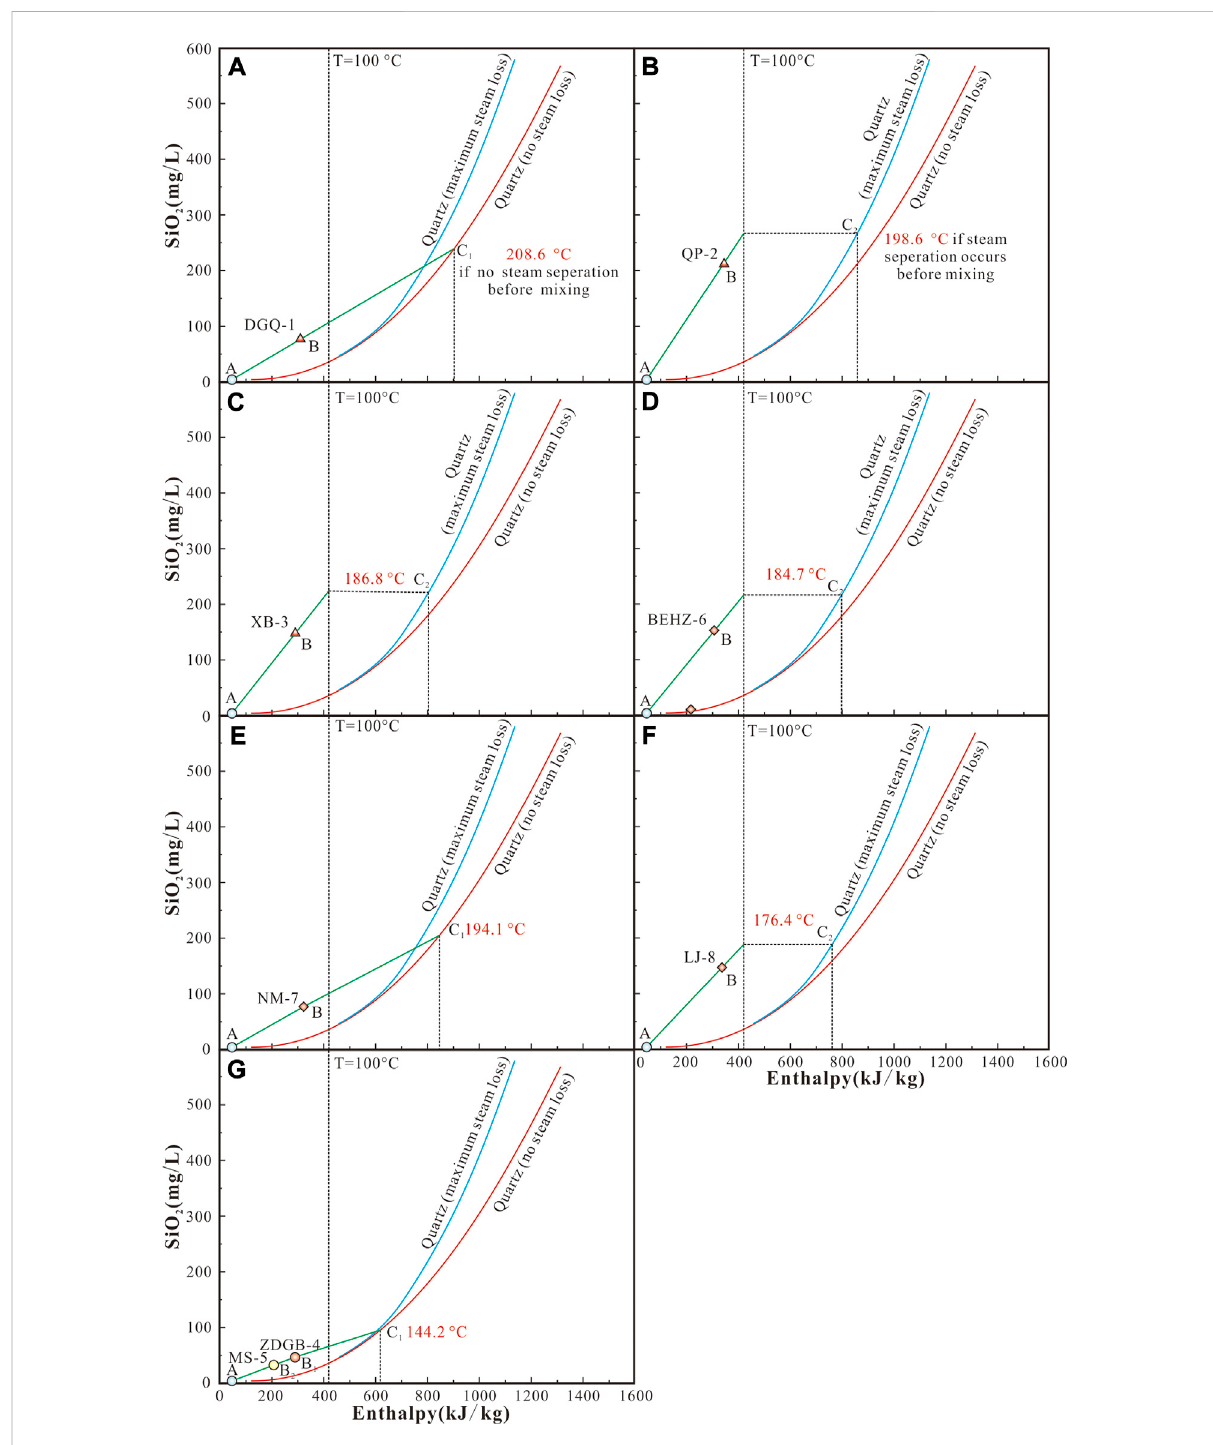
FIGURE 9 Plots of enthalpy versus silica for geothermal spring waters along the KKF. The legend is the same as in Figure 2.